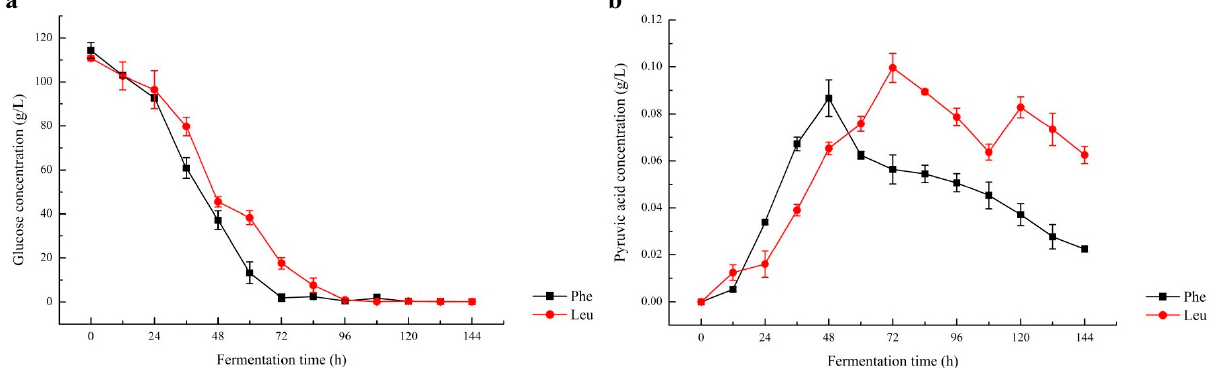
Figure 1. Changes in glucose ( a ) and pyruvic acid ( b ) of the simulated juice system with the addition